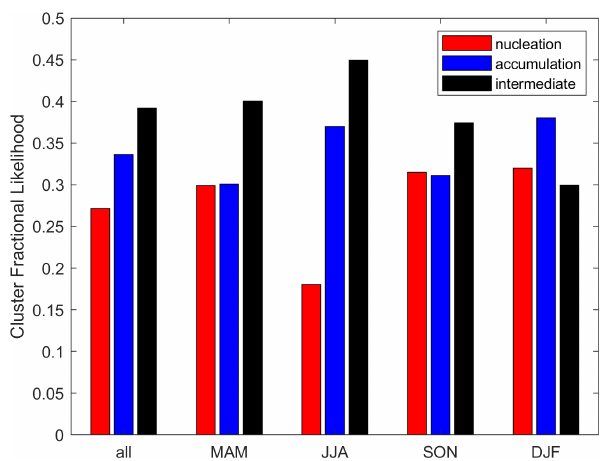
Figure 6. Diurnal variability in cluster fractional